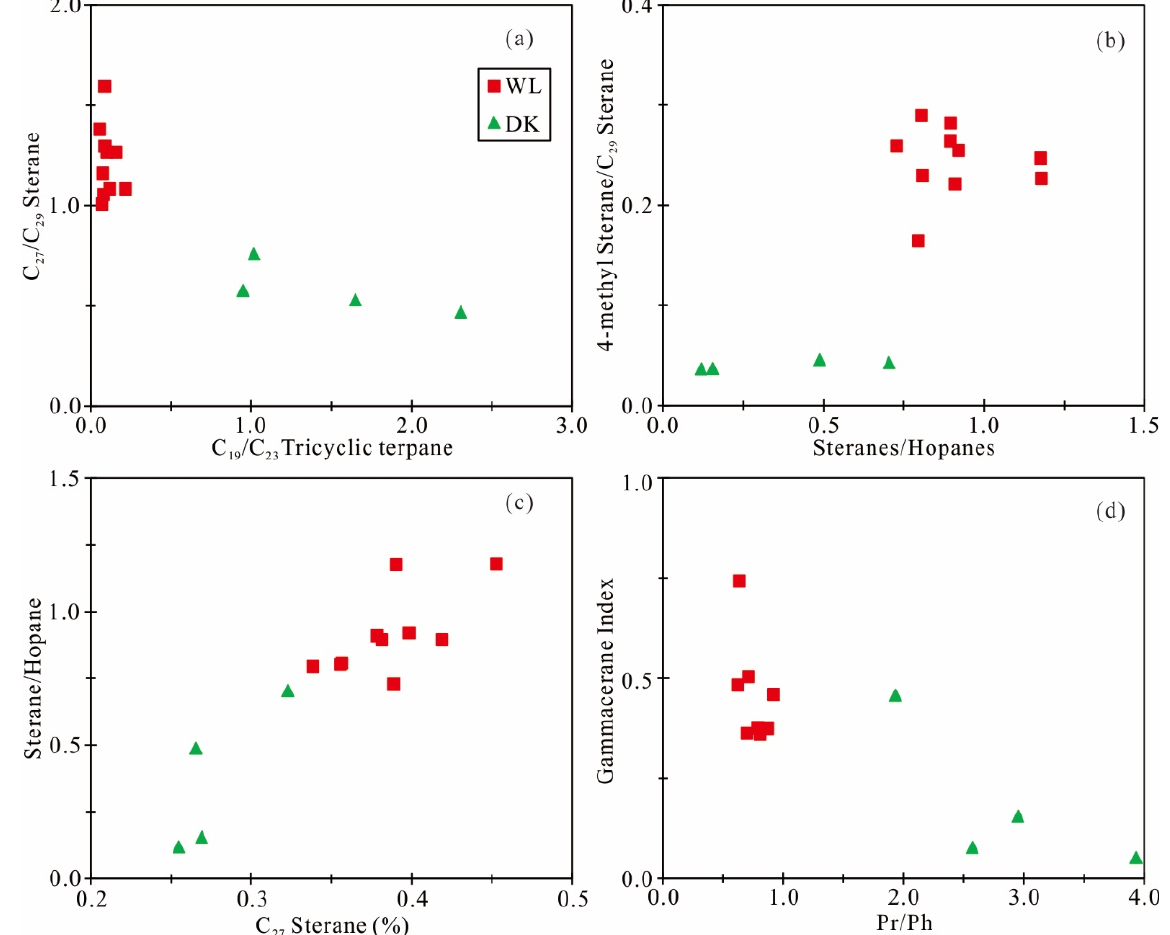
Figure 9. Correlation between various biomarker parameters reflecting organic matter input ( a – c ) and depositional environments ( d ) for the WL and DK samples.